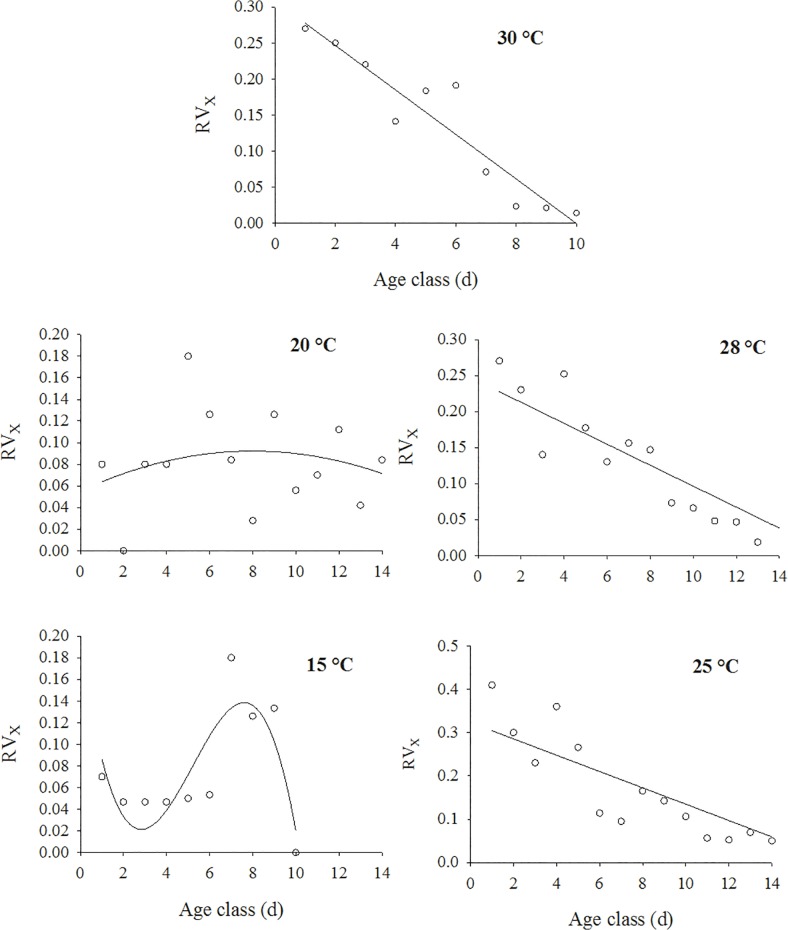
Reproductive value for apterous morphs of H. foeniculi as a function of temperature: 15°C (0.1939–0.1392x3 + 0.0337x2–0.0022x, F = 4.38, df = 3, 6, P = 0.0588, R2 = 0.6870); 20°C (0.0551 + 0.0093x2 - 0.0006x, F = 4.38, df = 3, 6, P = 0.0588, R2 = 0.6058); 25°C (0.3634–0.0254x, F = 43.29, df = 1, 12, P = 0.0001, R2 = 0.7829); 28°C (0.2712–0.0194x, F = 45.61, df = 1, 10, P = 0.0001, R2 = 0.8003); and 30°C (y = 0.3082–0.0308x, F = 64.93, df = 1, 8, P = 0.0001, R2 = 0.8903).